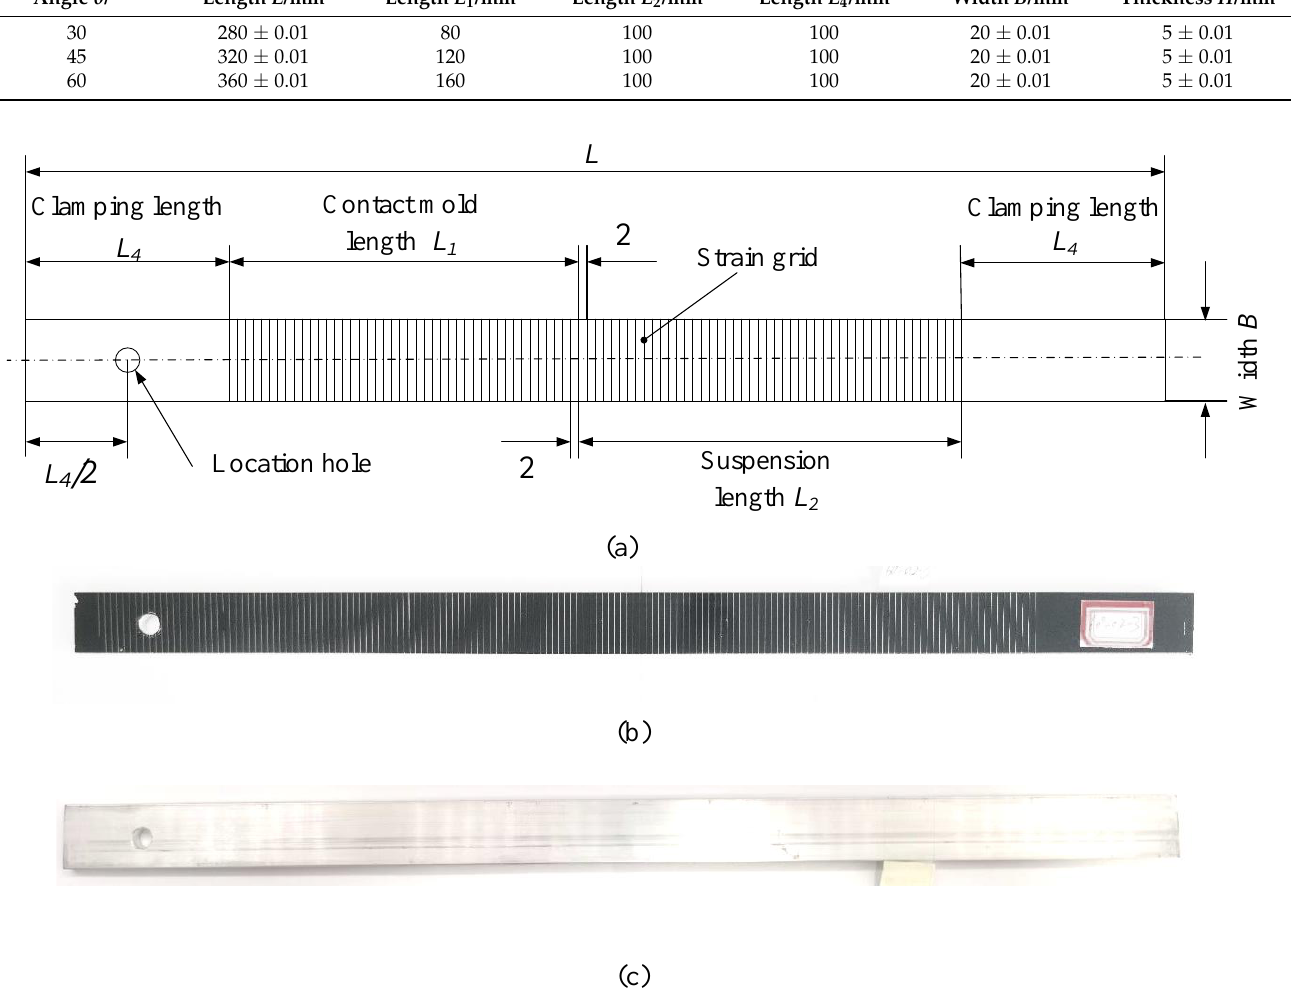
Figure 7. Structure size of the specimen. ( a ) Specimen size; ( b ) Upper surface of test sample; ( c ) Down surface of test sample.